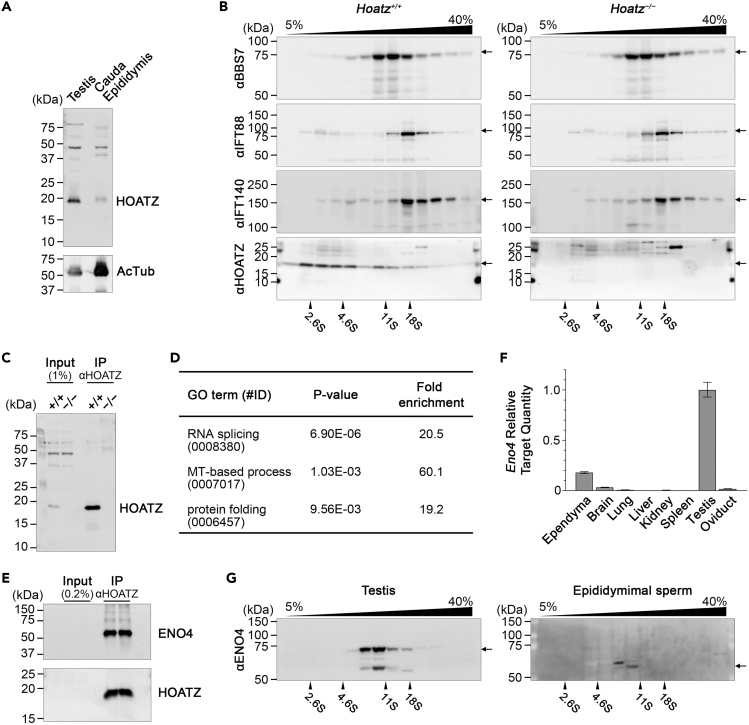
HOATZ Interacts with Enolase 4(A) Comparison of endogenous HOATZ levels between testis and cauda epididymis containing mature sperm in wild-type mice. AcTub served as a marker of cilia and flagella.(B) Comparison of BBS7, IFT88, and IFT140 levels between wild-type and Hoatz−/− mouse testes. Tissue homogenates were fractionated using sucrose density gradient centrifugation and concentrated using TCA precipitation. The levels of BBS7, IFT88, IFT140, and HOATZ were analyzed using western blotting with the respective antibodies.(C) Immunoprecipitation for shotgun proteomics. Testis homogenates from wild-type and Hoatz−/− mice were incubated with a rabbit polyclonal anti-HOATZ IgG cross-linked to magnetic beads, and the eluates were subjected to LC-MS to detect potential HOATZ-binding proteins. HOATZ levels in the eluates were determined using western blotting.(D) Gene Ontology analysis of proteins eluted from of the anti-HOATZ immunoprecipitates. A dataset comprising 27 HOATZ-associated proteins was analyzed using the DAVID server (Huang et al., 2009).(E) Western blot analysis of ENO4 eluted from immunoprecipitates.(F) Real-time PCR analysis of Eno4 mRNA levels using the comparative CT method. The ΔΔCT values were calculated using B2m as an endogenous reference and testis as a calibrator. The data are expressed as the mean, minimum, and maximum relative target quantities (n = 3).(G) Western blot analysis of ENO4 levels in the homogenates of testis and cauda epididymis containing mature sperm.See also Figure S6 and Data S1 and S2.